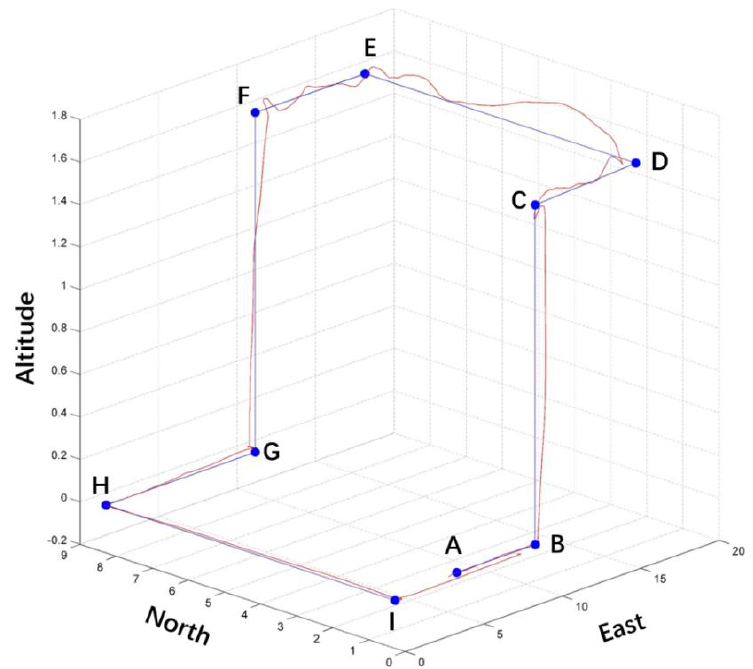
Figure 22. Actual land – air trajectory of the